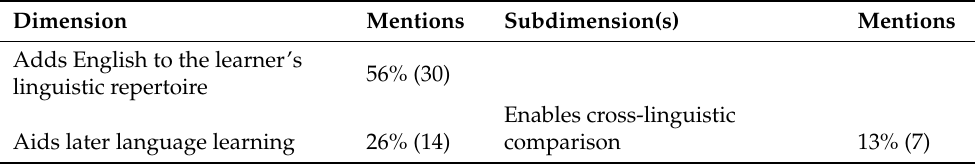
Table 7. Main dimensions and main subdimension (where applicable) of participants’ cognition about the positive contribution that learning English at school can make to multilingualism. Mentions are given as a percentage of the total number of participants, followed by the absolute number of mentions. More than one theme or subtheme can be present in a single participant’s answer. Dimension Mentions Subdimension(s)